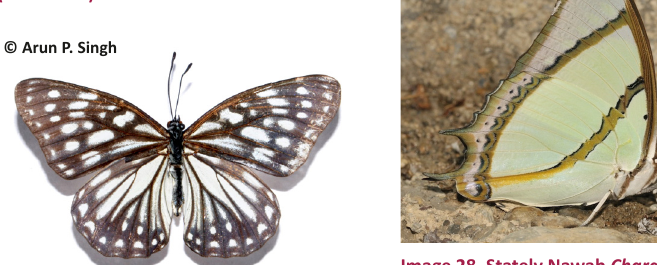
Image 26. Siren Hestina persimilis zella (Underside) — Devalsari